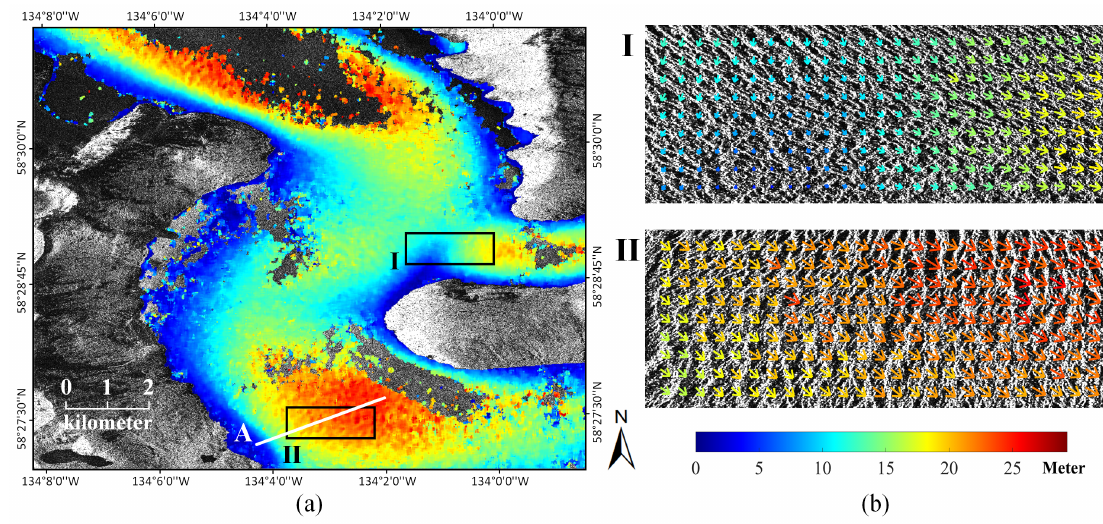
Figure 6. ( a ) Magnitudes of surface motions over the glacierized regions of the Taku Glacier; and ( b ) motion field of the glacier surface in the selected